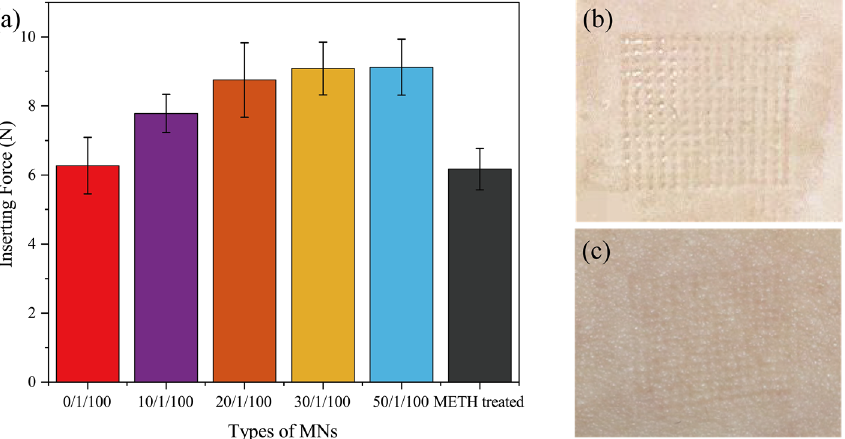
Figure 5. Penetration performance test of MT/SF@MNs: ( a ) penetration force of different MNs, ( b ) rabbit skin after penetration, and ( c ) rabbit skin 5 min after the removal of MNs.